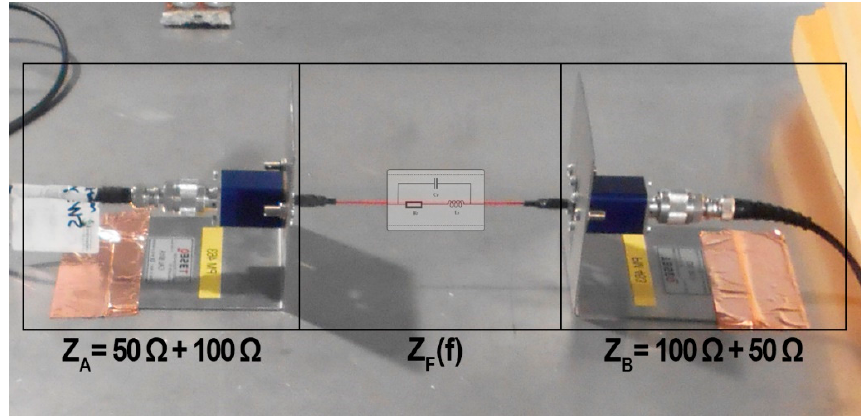
Figure 11. Experimental measurement setup for characterizing NC and ceramic sleeve ferrite cores in terms of